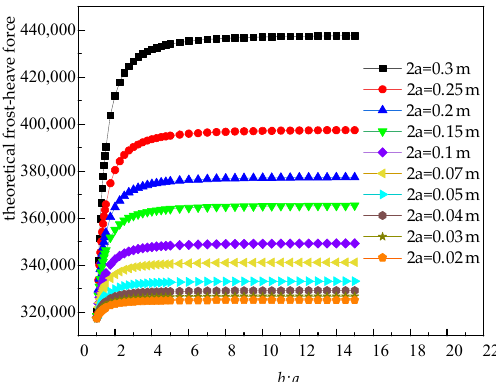
Figure 7. Relationship between theoretical frost heaving force and crack ratio.